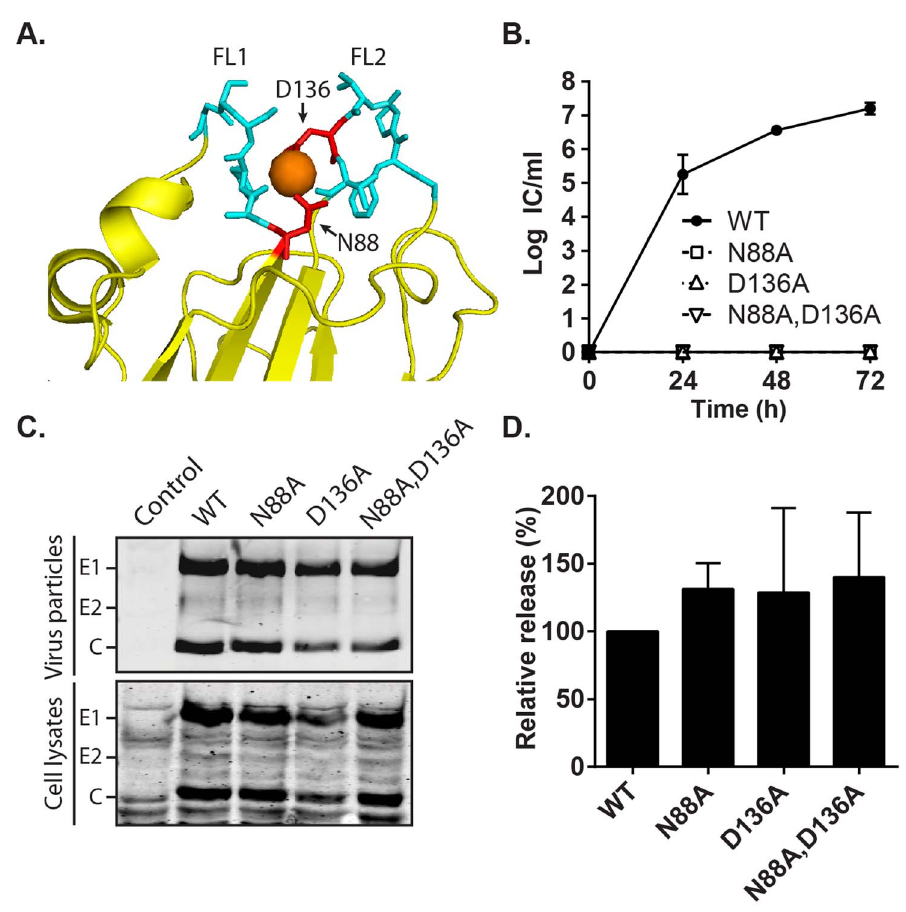
Figure 7. Effect of mutation of the RuV E1 Ca 2 + -coordinating residues on virus replication. (A) Close-up view of the tip of RuV E1 domain II [28] (PDB 4B3V). The two fusion loops are shown in cyan, the bound Ca 2 + cation as an orange sphere, and the Ca 2 + -coordinating residues D136 and N88 in red. (B) Growth kinetics. BHK-21 cells were electroporated with the indicated viral RNAs, the growth medium collected at the indicated time points, and the progeny virus quantitated by infectious center (IC) assays. Data shown are the mean and range of 2 independent experiments. (C–D) Assembly assays. BHK-21 cells were electroporated with the indicated viral RNAs, and the growth medium and cell lysates harvested at 48 h. Virus particles in the medium and viral proteins in the lysates were visualized by SDS-PAGE and Western blot. (D) Quantitation of assembly assays performed as in (C). Graphs show the mean and standard deviation of 3 independent experiments, with release normalized to that of WT RuV.